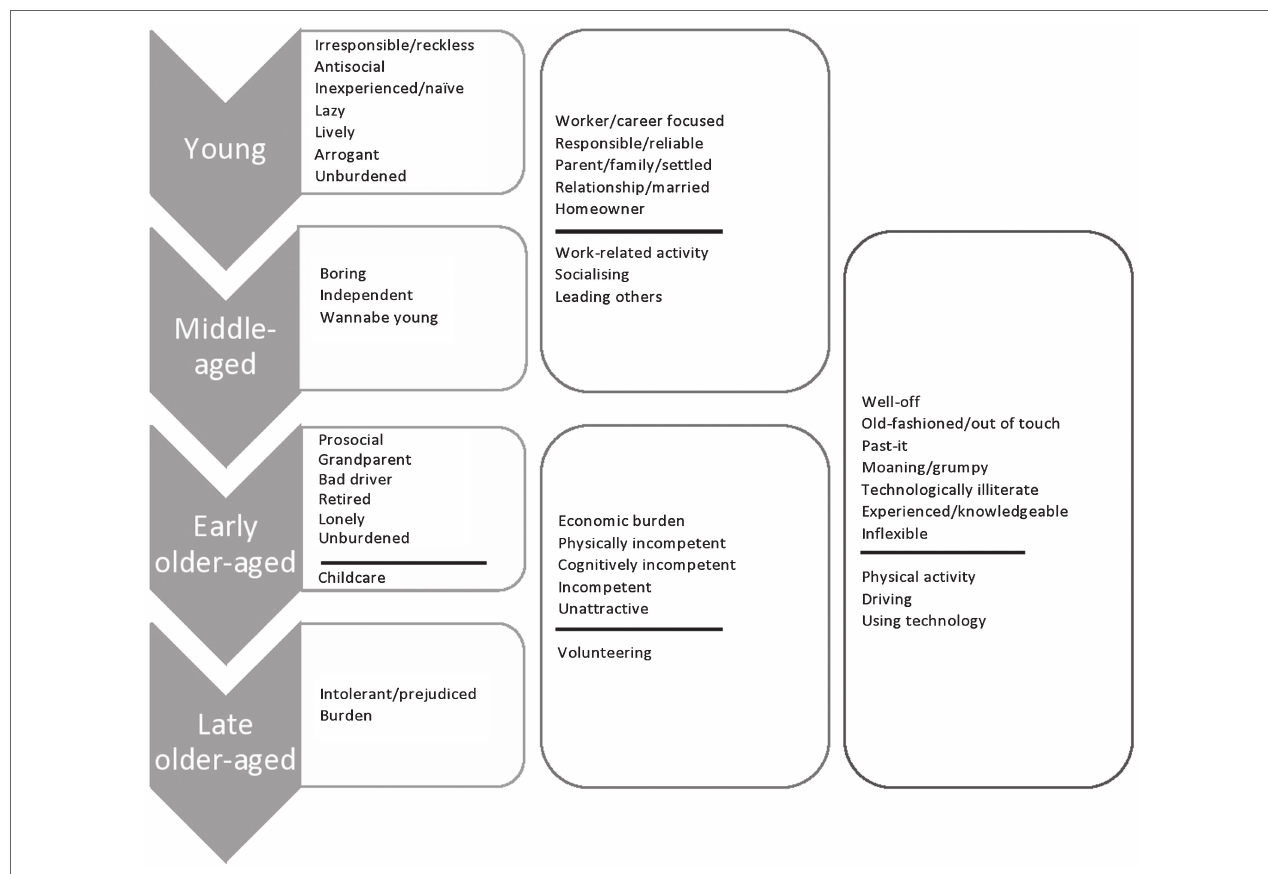
FIGURE 1 | Study 1: Age-based judgement